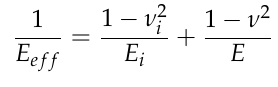
Figure 7. Schematic representation of indenter ‐ sample contact cross section ( a ) and a graphical view of load ‐ displacement data ( b ).